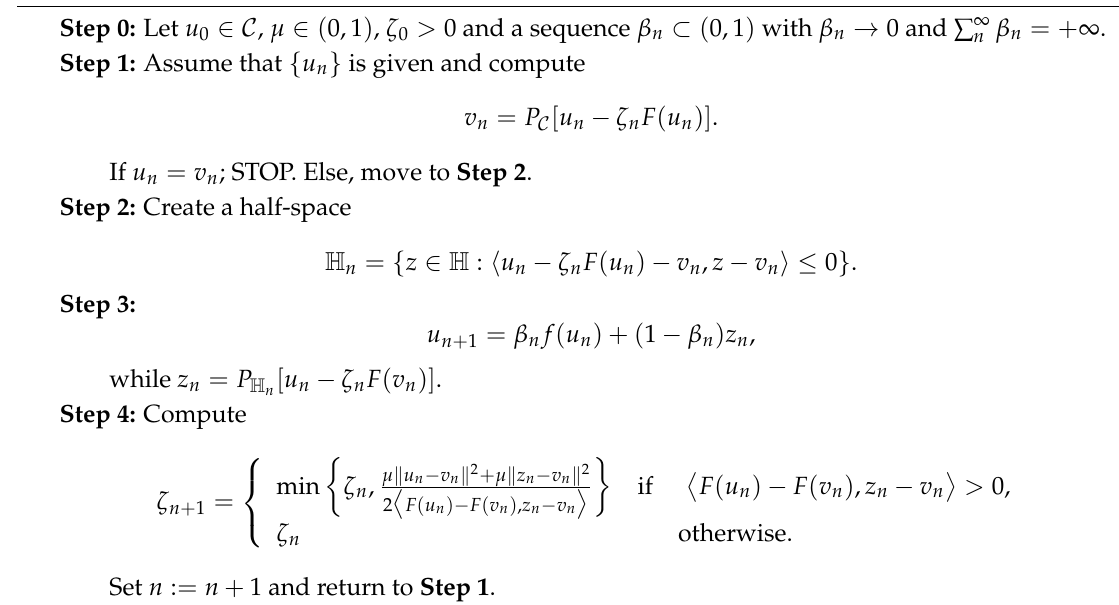
Algorithm 1 An Explicit Method for Monotone Variational Inequality